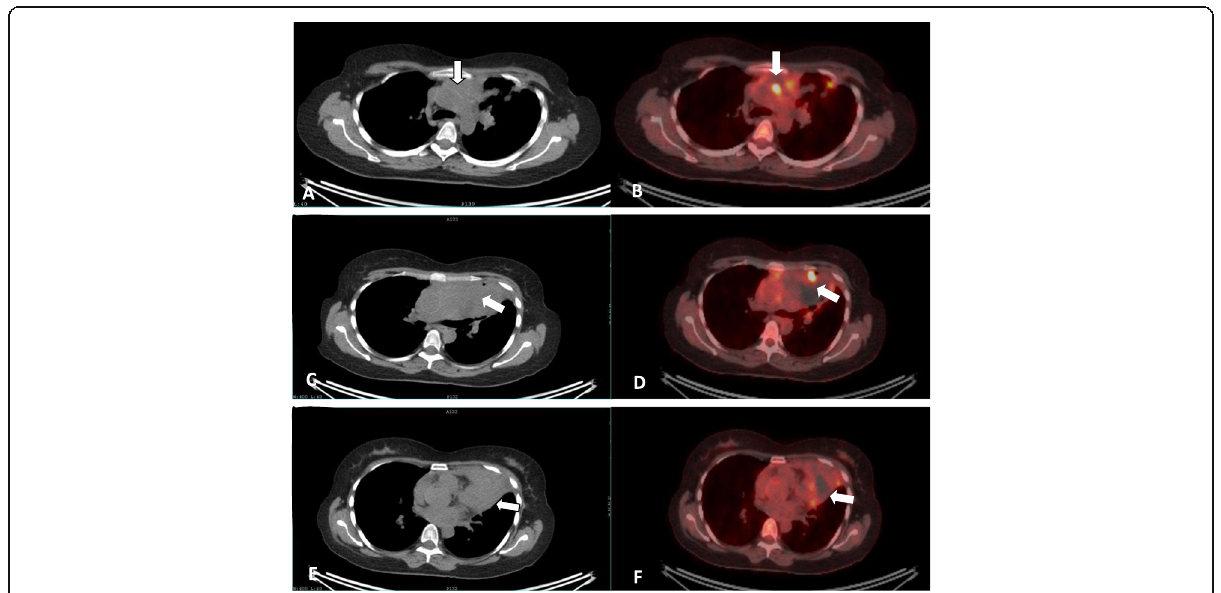
Fig. 2 Thirty-five-year-old female patient, known case of lymphoma. a – f Anterior mediastinal mass lesion comprising matted lymph nodes. This necrotic infiltrative lesion measures 8 × 6 × 5 cm, showing preferential avid FDG uptake of SUV max 21.4, consistent with a score of 4 on the five-point